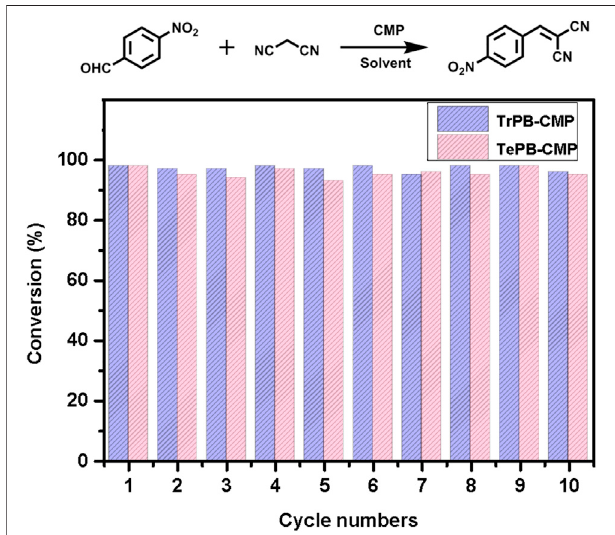
FIGURE 3 | Recyclability of TrPB-CMP (blue) and TePB-CMP (red) as catalysts with p -nitrobenzaldehyde as the